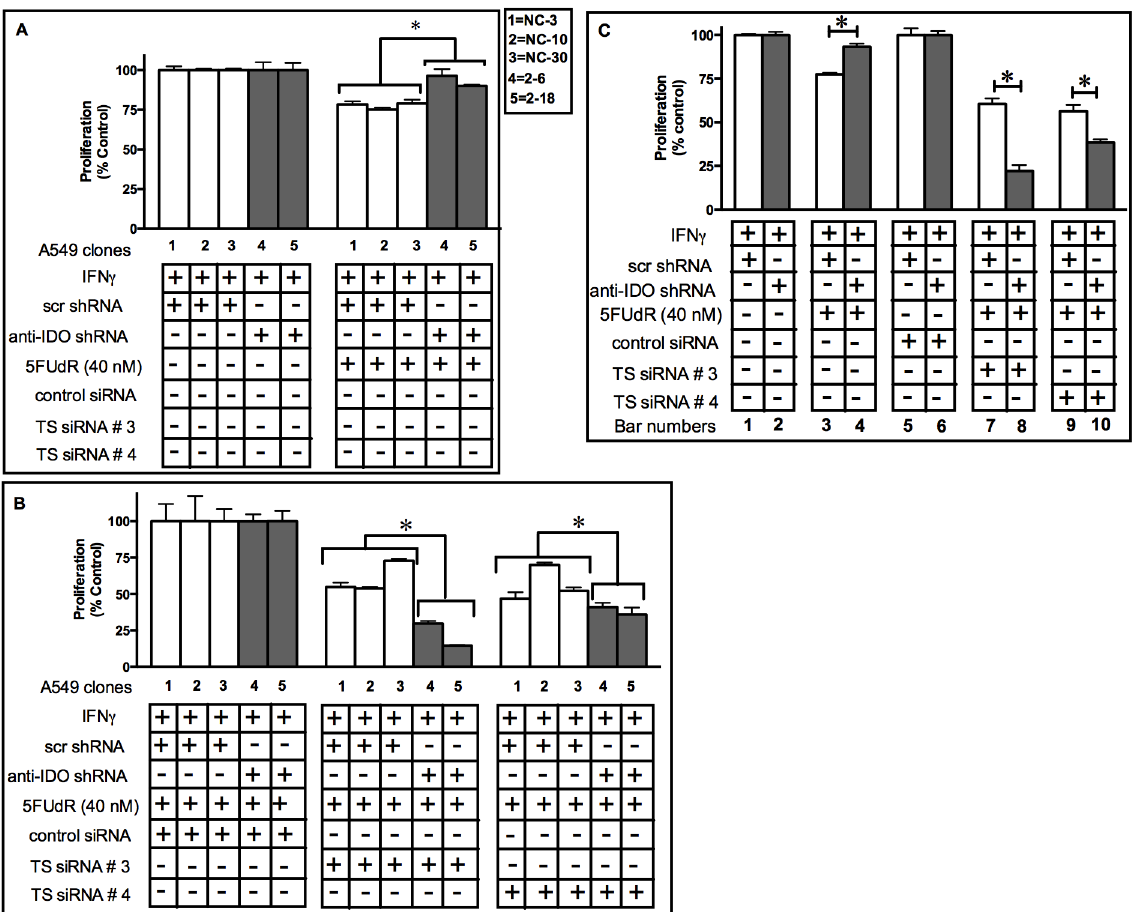
Fig 8. Concurrent IDO and TS downregulation sensitizes A549 cells to 5FUdR more than TS knockdown alone. A549 cells were transfected with control or anti-thymidylate synthase (anti-TS) siRNA, treated with IFN γ (25 ng/ml) for 48 h, with 5FUdR (40 nM) for 72 h, and then enumerated. Bars indicate mean proliferation relative to appropriate controls ± SD (n = 3). A : Proliferation of clonal A549 cell populations induced with IFN γ and then treated with 5FUdR, but untransfected with siRNA of any kind. Gray bars : clones containing anti-IDO shRNA. White bars : clones containing non-targeting control shRNA. B : Proliferation of the same clonal A549 cell populations transfected with control non-targeting siRNA, TS siRNA #3, or TS siRNA #4, induced with IFN γ , and then treated with 5FUdR. Bars represent values normalized to values obtained from clones treated with IFN γ but untreated with pemetrexed or siRNA; those cells were considered to have a proliferation value of 100% after IFN γ treatment. Gray bars : clones containing anti-IDO shRNA. White bars : clones containing non-targeting control shRNA. * Significant difference, Student's t -test, p < 0.05. Data presented a representative experiment from two independent experiments. Results are normalized to control cells not treated with 5FUdR, but with treated with IFN γ . Panel C : shows the pooled results from panel A and B.